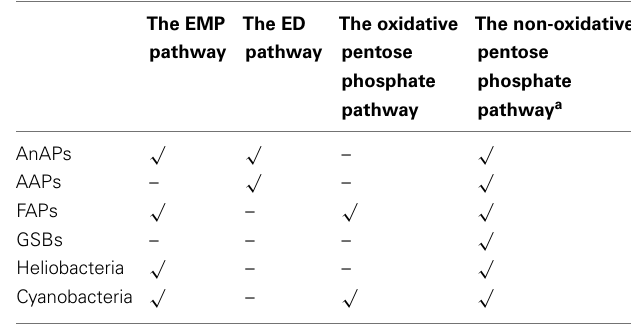
Table 3 | The carbohydrate catabolic pathways reported in phototrophic